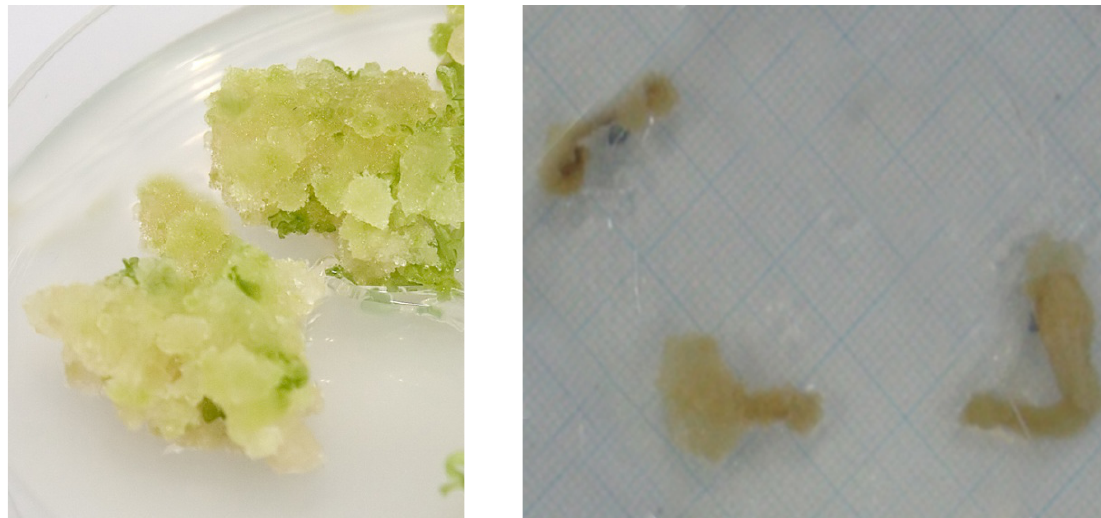
Fig. 1. The inducted callus in leaf (left) and hypocotyl (right) explants in Cuminum cyminum L. Table 1 . Mean squares for explant and hormone effects on callus induction percentage and callus growth rate in Cuminum cyminum L.